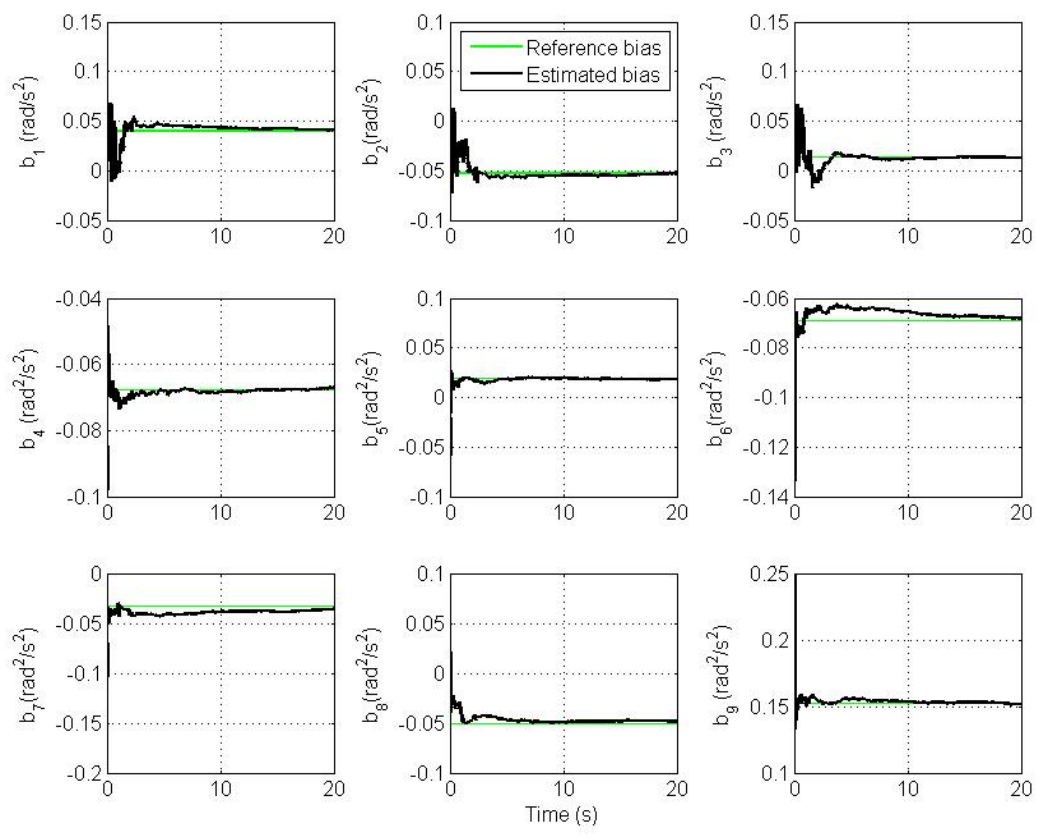
Figure 6. Estimated and reference bias parameters in the